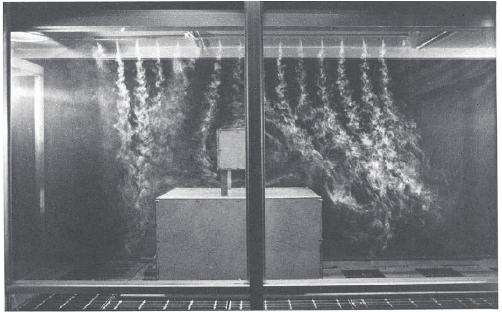
Figure 9: Kanayama et al.’s experimental